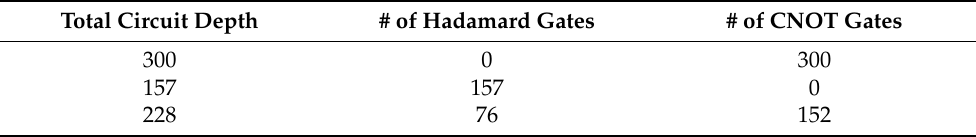
Table 1. Estimation of total number of Hadamard and CNOT Gates that can be performed on Armonk for the two-qubit